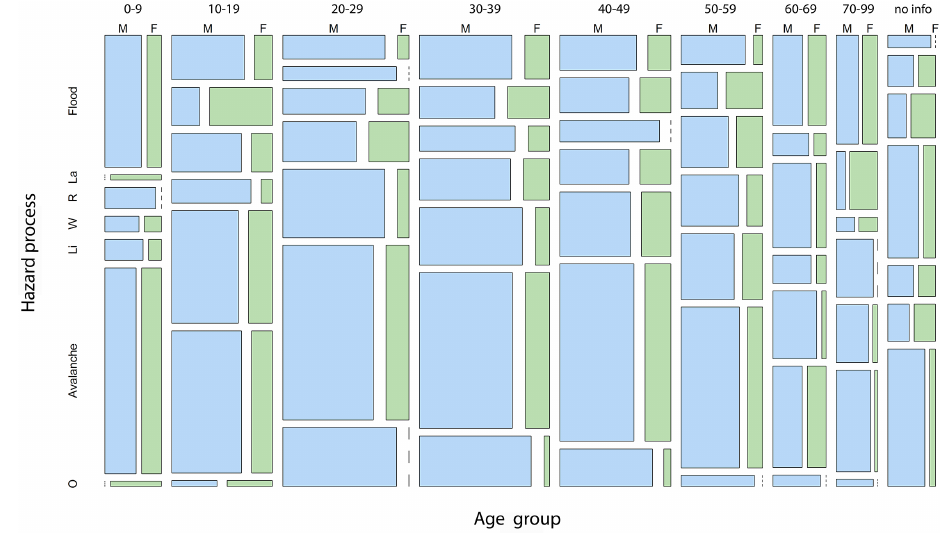
Figure 11. Mosaic plot showing age groups and gender (M is male, F is female) for natural hazard fatalities in Switzerland (1946–2015). Fatalities are subdivided according to the hazard category (flood, La is landslide, R is rockfall, W is windstorm, Li is lightning, avalanche and O is other). Also see Table